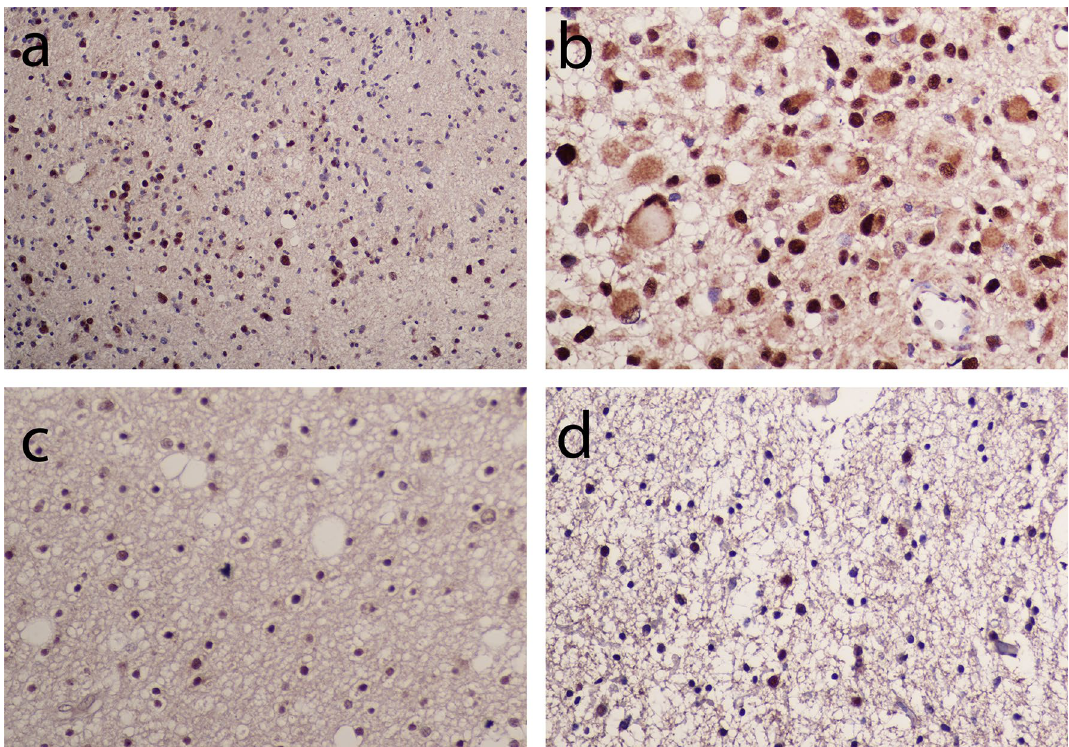
Figure 9. Immunohistochemistry for dystrophin in LGG. Representative images of grade II astrocytoma ( a ), gemistocytic astrocytoma ( b ), oligodendroglioma ( c ) and NOS ( d ). Images were taken at × 20 magnification except for image ( b ) which was taken at × 40 magnification to better visualise the gemistocytic